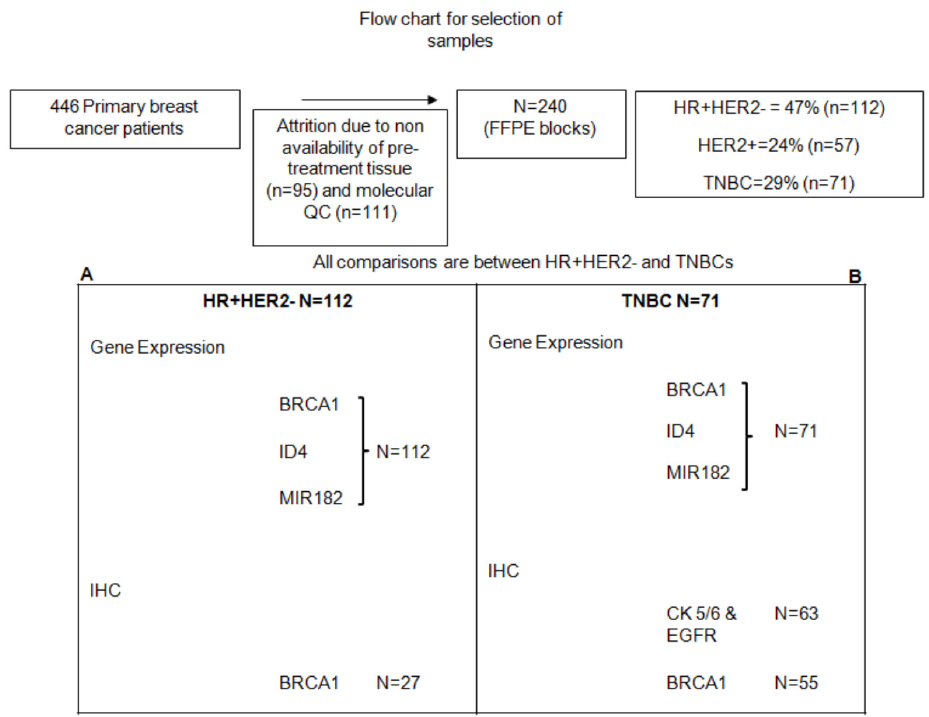
Fig 1. Identification of BRCA1 deficiency using multi-analyte estimation of BRCA1 and its repressors in FFPE tumor samples from Indian patients with Triple Negative Breast Cancer. Flow chart depicting sequential elimination of tumors based on availability and QC criteria and the proportions of the sub-types used in this study. Panel A & B show the detailed break-up of numbers from each of the sub-types used in the different analytical tests. HR+: Hormone Receptor positive, TNBC: Triple Negative, QC: Quality